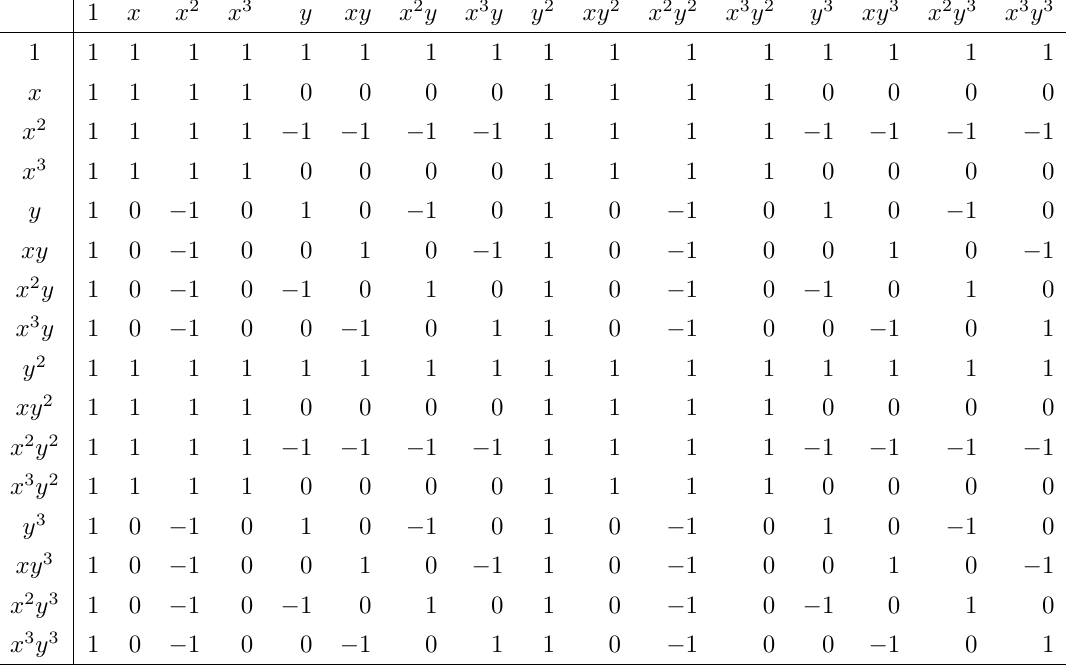
Table 10 . Twisted sector phases for discrete torsion in a Z 4 o Z 4 orbifold. A zero entry indicates a non-commuting pair of group